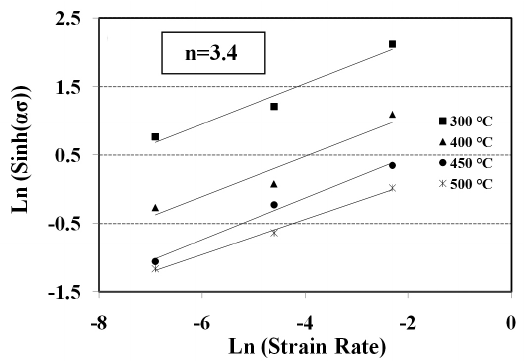
Figure 4. Relationship between ln [sinh ( ασ )] and 1000/T of rolled